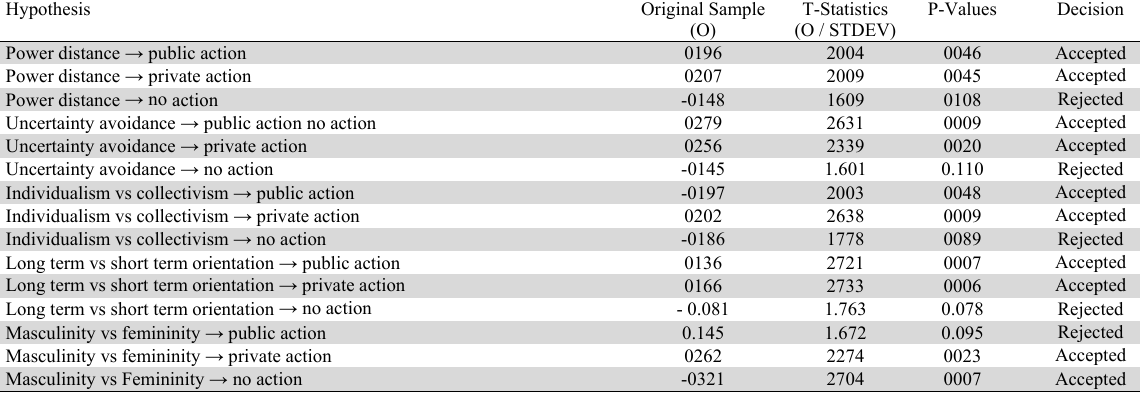
Hypothesis Test